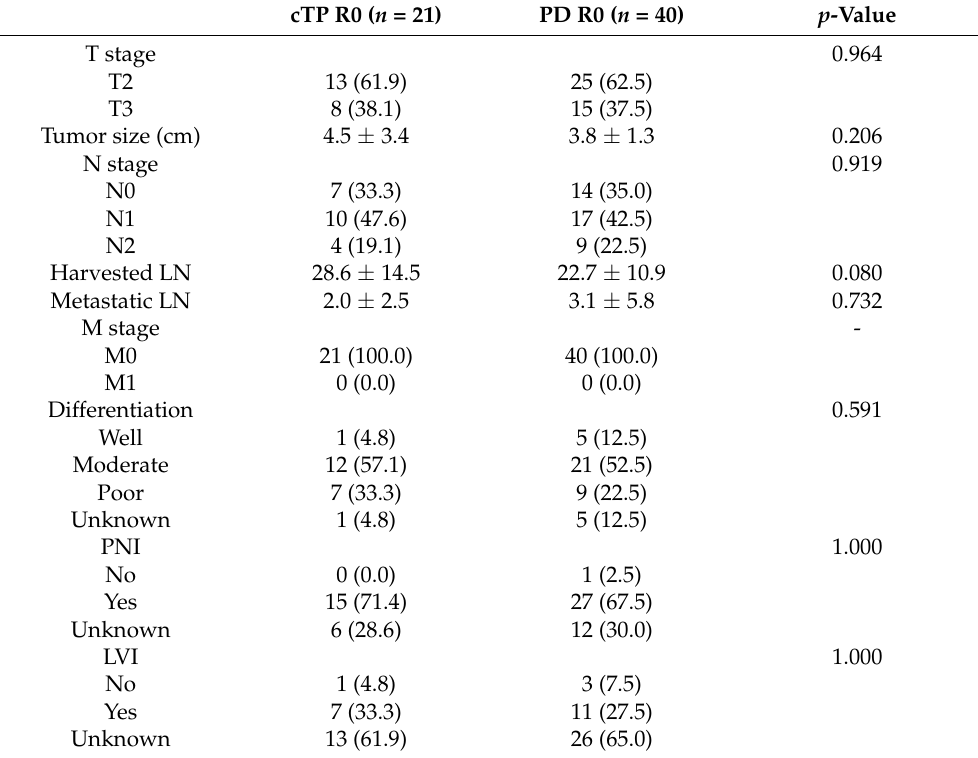
Table 3. Comparison of pathological characteristics between cTP R0 group and PD R0 group extracted by PSM (number (percent) and mean ± standard